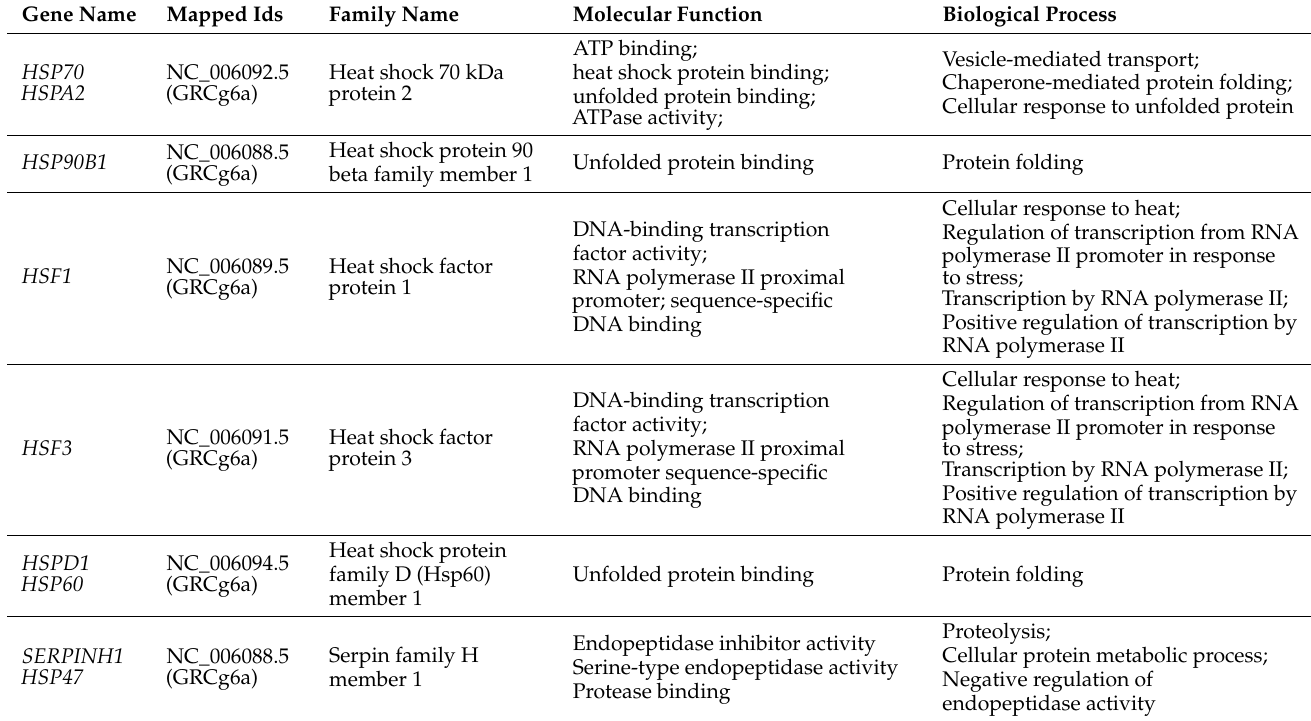
Figure 3. Schematic mechanism of heat shock protein (HSP) in cellular response against heat stress (HS). HSF = Heat-Shock Factor; HSE = Heat-Shock Element; DP = Denatured Protein; P = Phosphate. The expression of the HSP could be physiological or induced by different inputs such as HS. HSPs might be classified in several manners; here, we report the most used classification based on molecular weights: HSP100 , HSP90 , HSP70 , HSP60 , small HSPs, and chaperonins [107]. Aside from the molecular chaperone activity, small HSPs are also involved in other cellular pathways such as stress tolerance, protein folding, cytoskeletal integrity, and cell cycle [108]. In most cases, HSPs are found in the cytoplasm, but it is also possible to find their presence in the extracellular matrix, in which they could serve as stress alarms and stimulate immune cells [107]. Table 1 briefly summarizes the most studied HSPs and HSFs, the biological processes in which they are involved, and their molecular function in chickens. Table 1. Using the Panther Classification System , the gene ontology of the most important genes related to heat stress was performed on two domains (molecular function and biological process). The current red jungle fowl ( Gallus gallus ) genome assembly, GRCg6a.